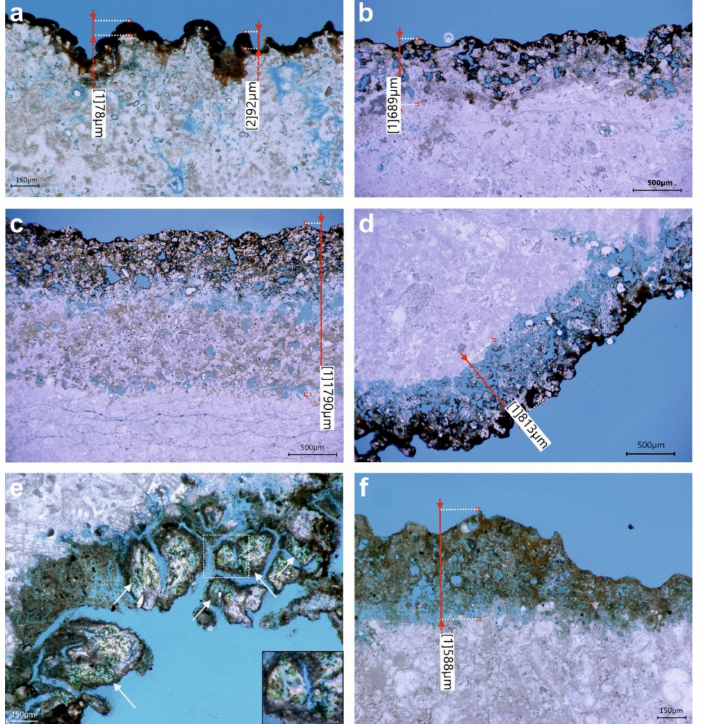
Figure 5. Pictures of the petrographic thin sections acquired with the Keyence digital microscope in transmitted light: ( a ) detail of the black varnish and of the reddish layer underneath it of sample AV1; ( b – d ) examples of the weathered area occurring beneath the black coating in samples EZ1, EZ3 and AV2; ( e ) weathered area colonized by cyanobacteria aggregates in sample AV1; ( f ) detail of the orange crust of sample